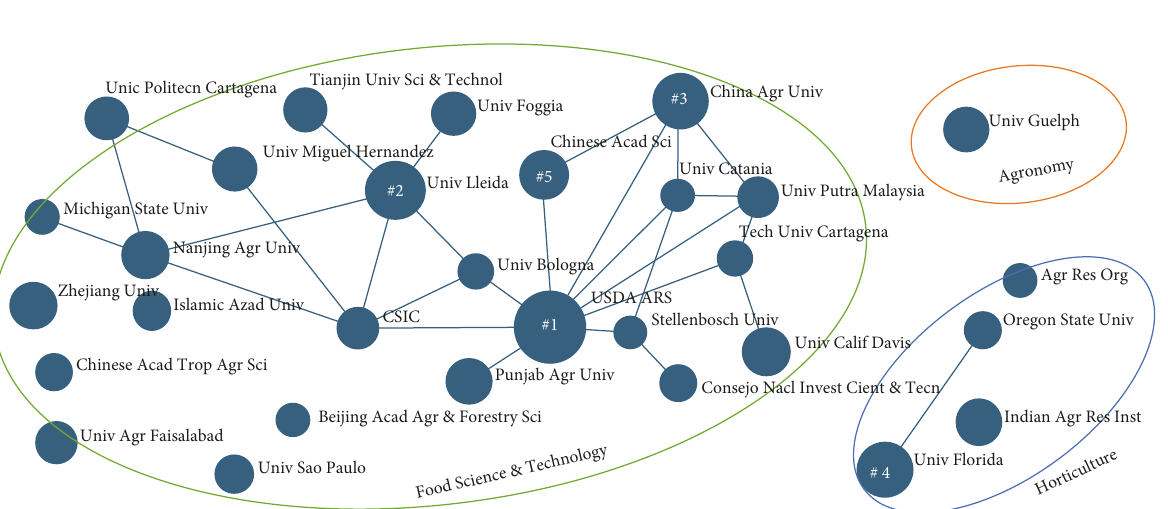
Figure 5: The cross-correlation map of the top 30 science-producing organizations and associates research themes (nodes numbered one through five represent the five organizations with the most publications in descending